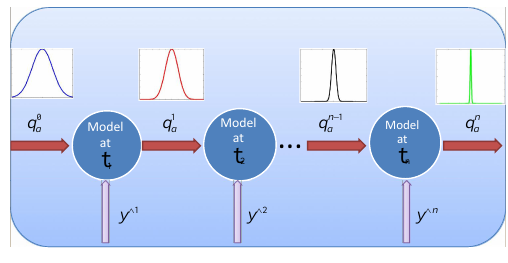
Figure 1. Sequential GMKF